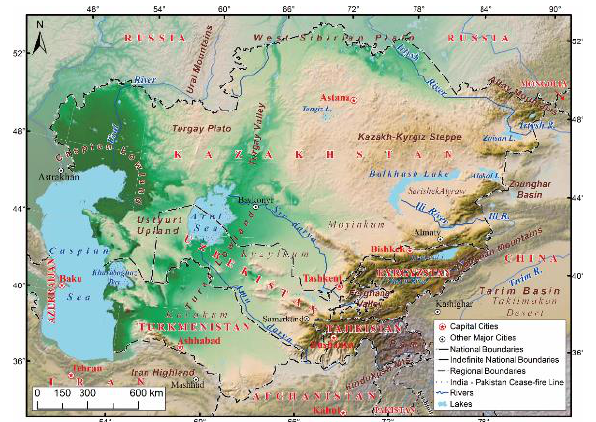
Figure 1. The location map of Central Asia (Source from: Chen and Zhou, 2015)